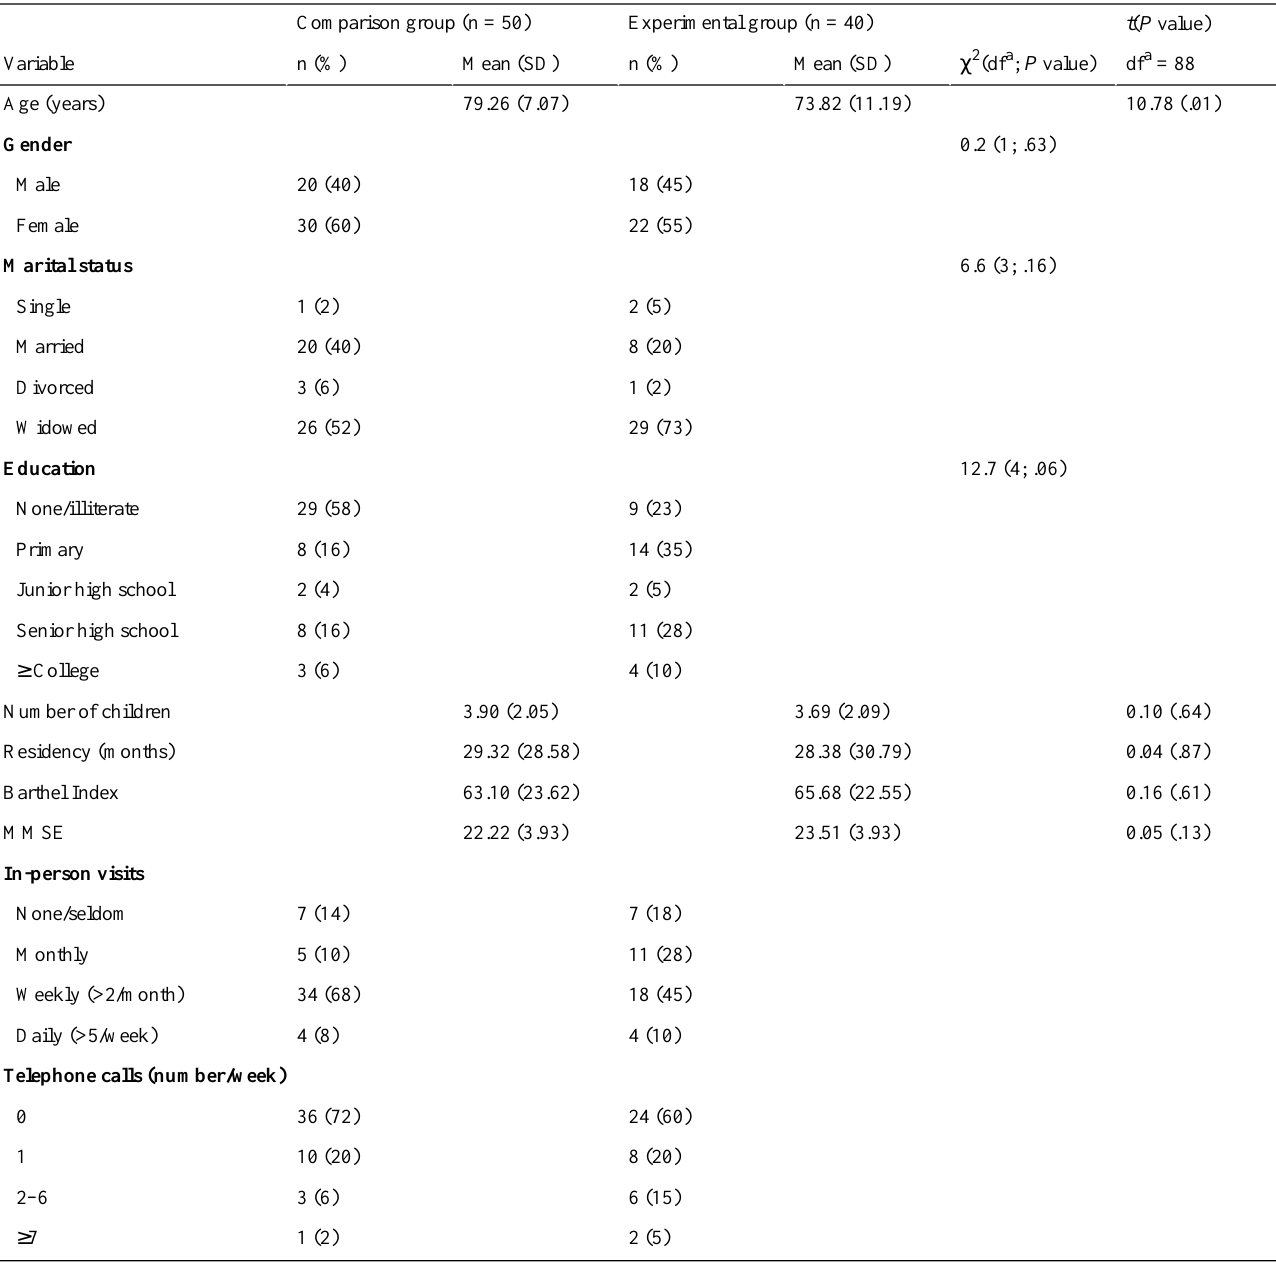
Table 1. Demographic characteristics of experimental and comparison